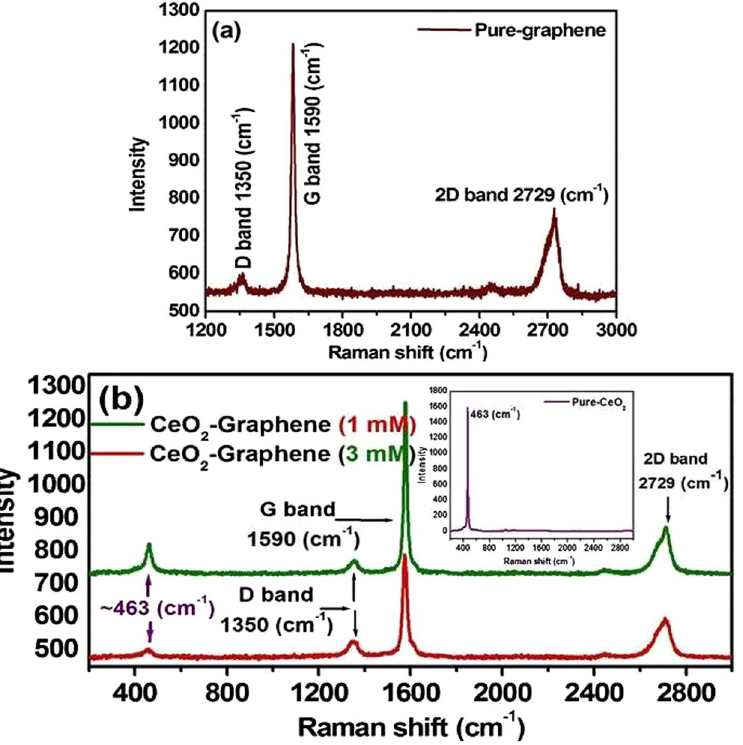
Figure 2. Raman spectrum of ( a ) pure-graphene, and, ( b ) 1 mM and 3 mM CeO 2 -Graphene nanostructures; the inset shows the Raman spectrum of pure-CeO 2 NPs.